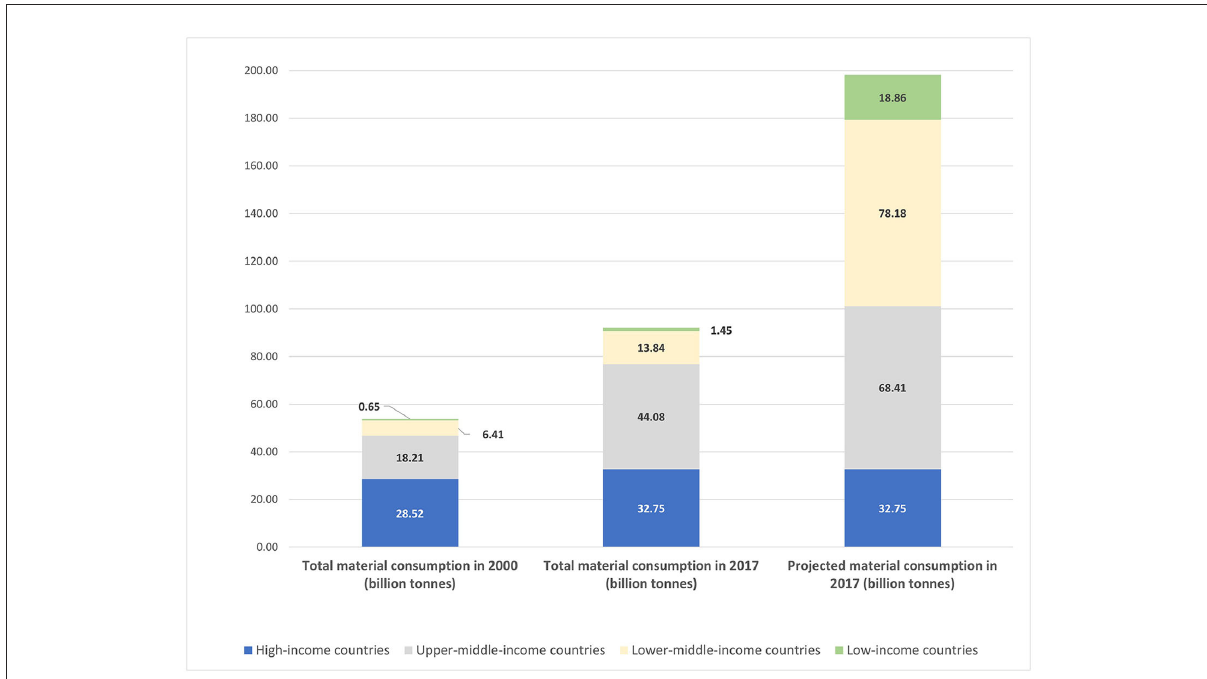
FIGURE1 Total material consumption in 2000 (54 billion tons) and in 2017 (92 billion tons) with High-income, Low-income, Upper-middle-income and Lower-middle-income countries, with populations of 1.1 (1.3), 0.5 (0.7), 2.3 (2.6) and 2.3 (3) billion people, and total material consumption of 25.64 (26.27), 1.41 (2.02), 7.97 (16.93) and (2.81) 4.65 tons per capita in 2000 (2017), respectively (UN, 2021). If everyone in 2017 had the same footprint as the high income counties (26.27 tons per capita), total material consumption would be 192 billion